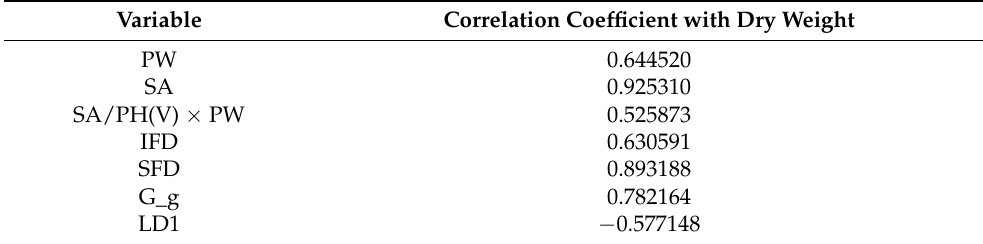
Table 3. Correlation coefficient between characterization and dry weight of rice.